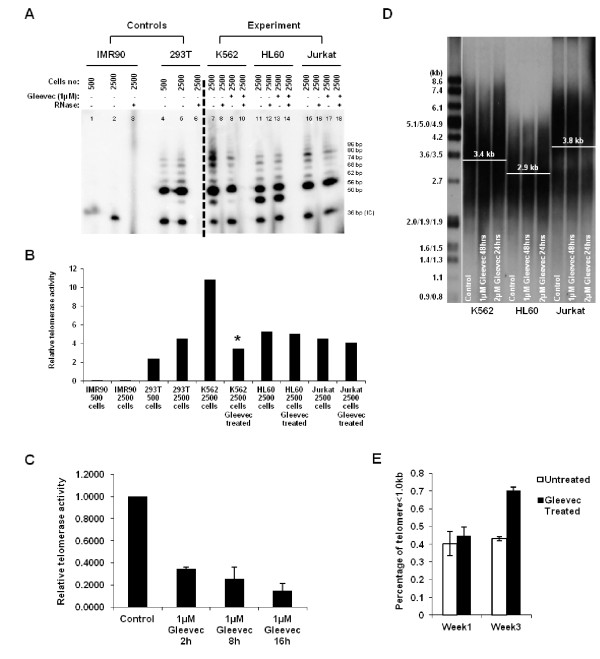
Gleevec reduces TA in K562 cells. (a) The Gel-based TRAP assay was performed with 32P-ATP labeled TS primer using the 2-step PCR conditions: 94°C/30 sec and 59°C/30 sec for 27 cycles. The amount of extract (expressed as cell number) present in telomerase-positive samples (293T, K562, HL60 and Jurkat) and negative controls (IMR90 and samples with RNase) is shown above each lane. K562, HL60 and Jurkat cells were subjected to 1 μM Gleevec treatment for 16 h. (b) Normalized relative TA from Gel-based TRAP assay was determined using ImageQuant TL in non-treated and 1 μM Gleevec treated K562, HL60 and Jurkat cells for 16 h. (c) Quantitative telomerase assay showing relative TA in K562 cells. Error bars represent standard deviation from three experiments. (d) Telomere length assay of K562, HL60 and Jurkat cells under Gleevec treatment. (e) Percentage of telomeres less than 1.0 kb as determined by STELA after 1, or 3 weeks with 0.05 μM Gleevec